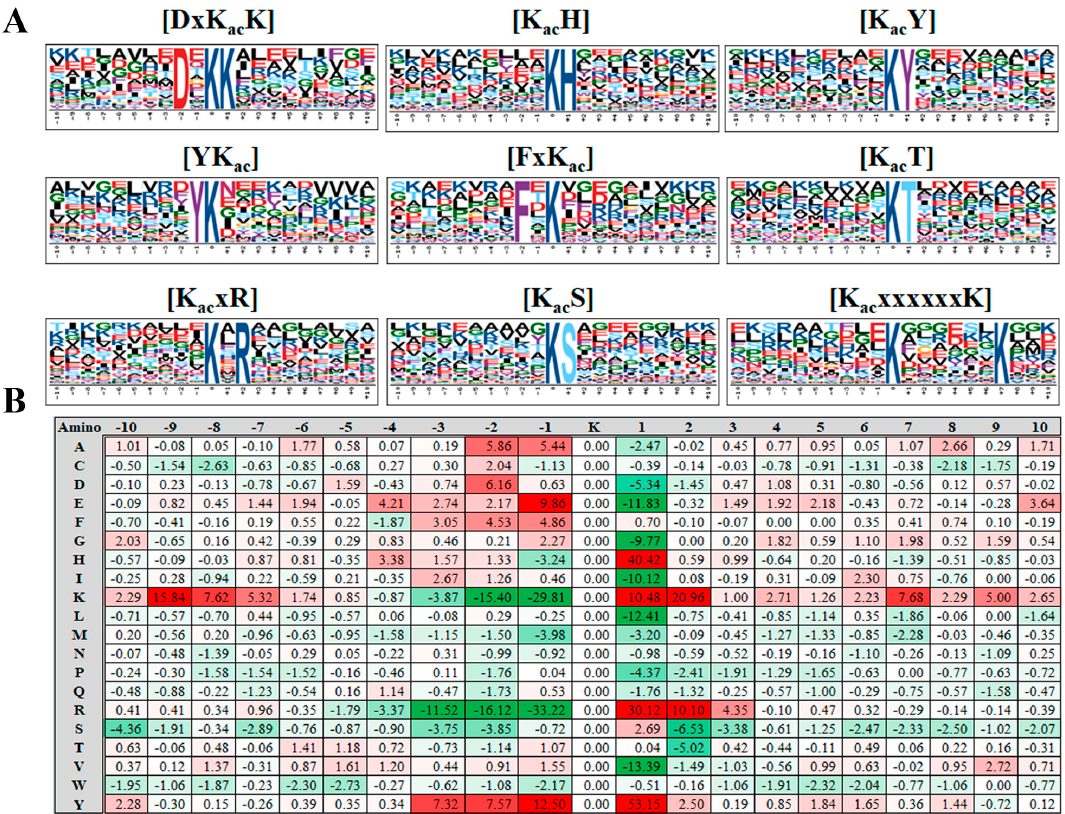
Figure 3. ( A ) Acetylation sequence motifs and conservation of acetylation sites in identified callus, leaf, panicle acetylproteins; and ( B ) Heat map of the amino acid composition of the acetylation sites, showing the frequency of different amino acids surrounding the acetylated lysine (K).